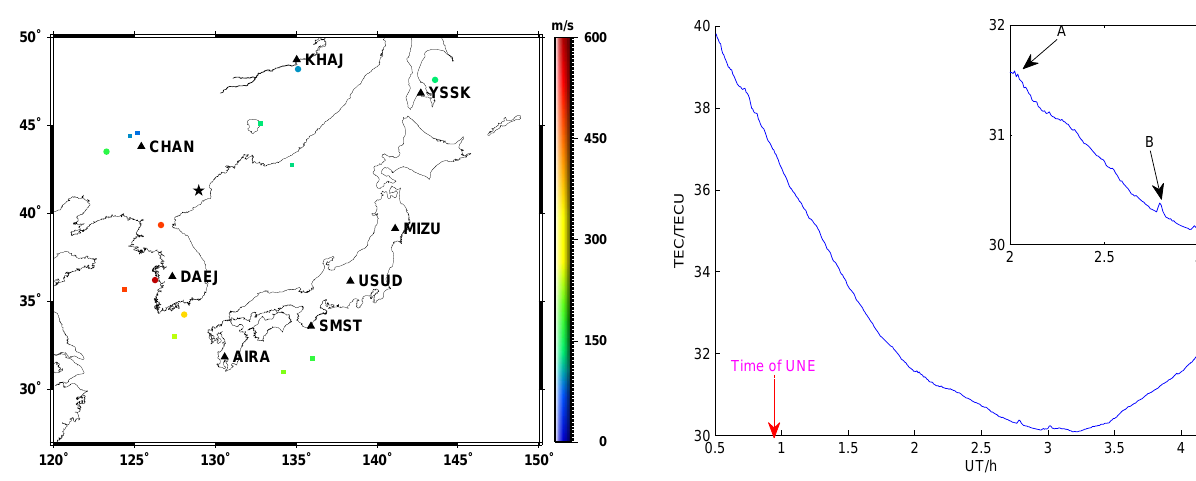
Figure 3. Ionospheric STEC obtained by GPS observations of satel- lite PRN 26 at station CHAN. The three arrows in top right indicate the arrival time of